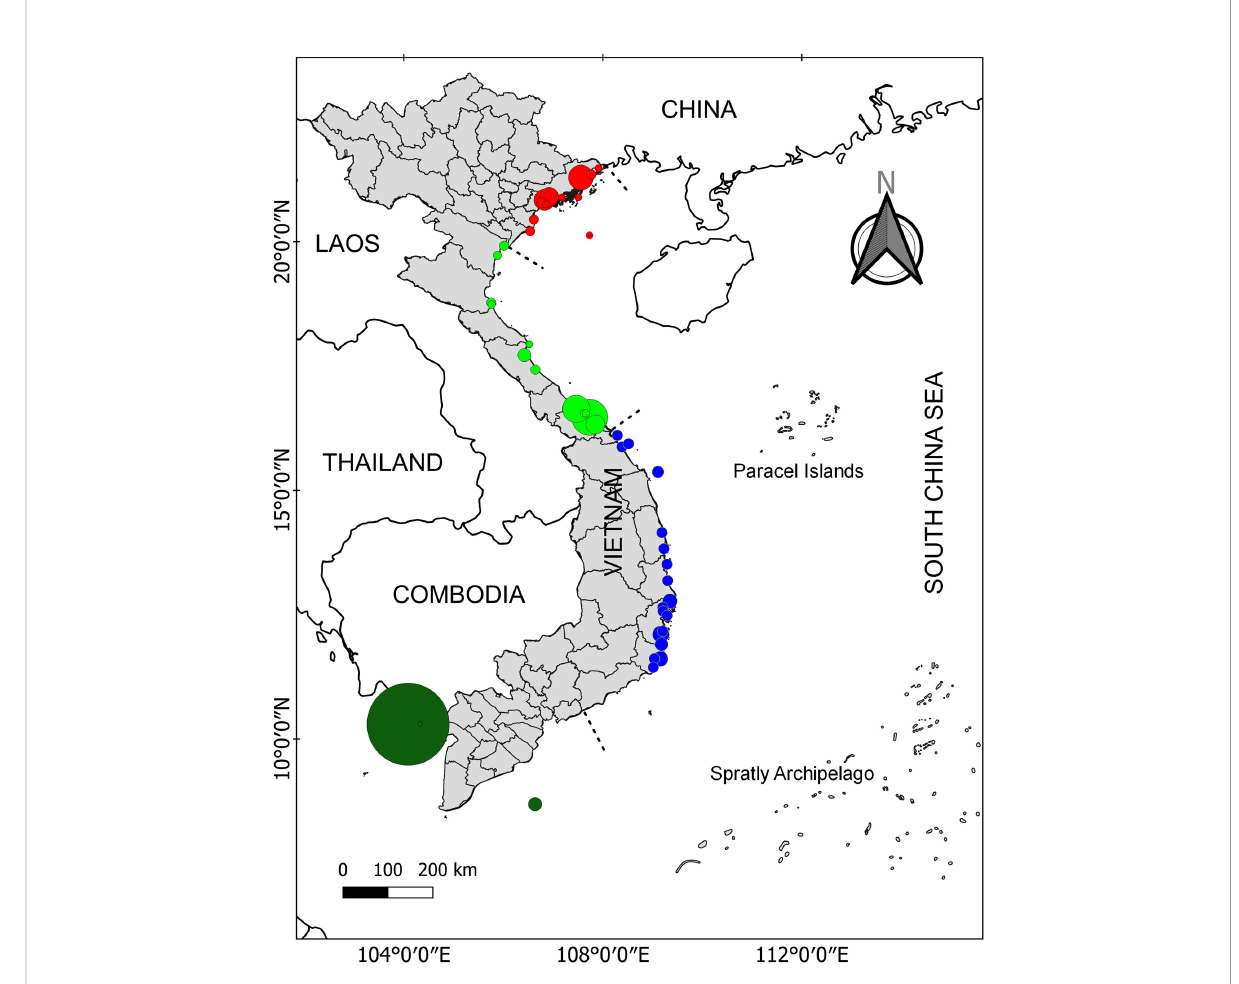
FIGURE 1 Seagrass distribution in Viet Nam. The four different color cycles indicate seagrass distribution in four different regions. Data were combined from various studies. See Table 1 for more